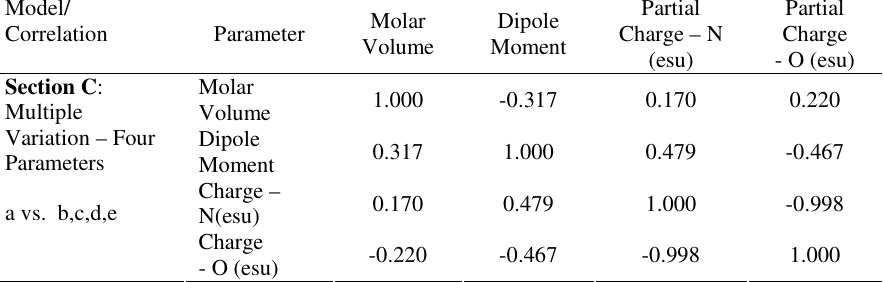
Table 3 Variation in the inter-dependence of the correlation parameters in the multiple four parameter variation Model/ Correlation